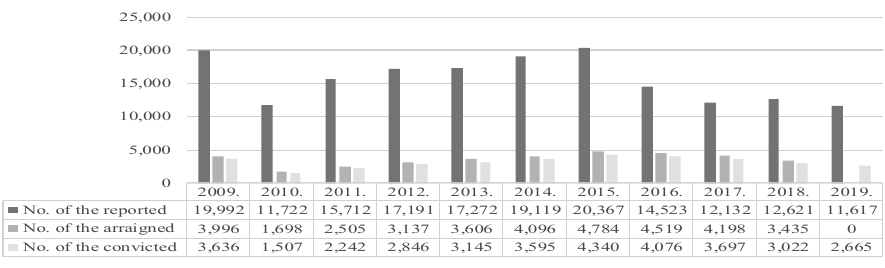
Chart 3: The number of the reported, arraigned and convicted persons of age in the territory of the Republic of Serbia for aggravated theft in the period between 2009 and